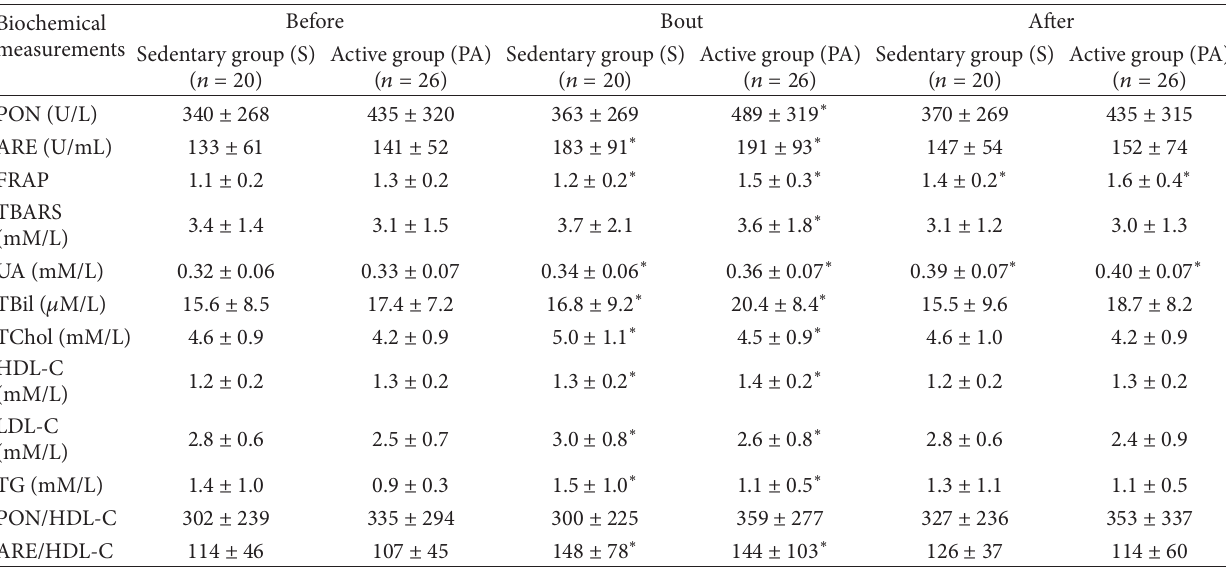
Table 2: Biochemical measurements at maximal exercise (mean ±